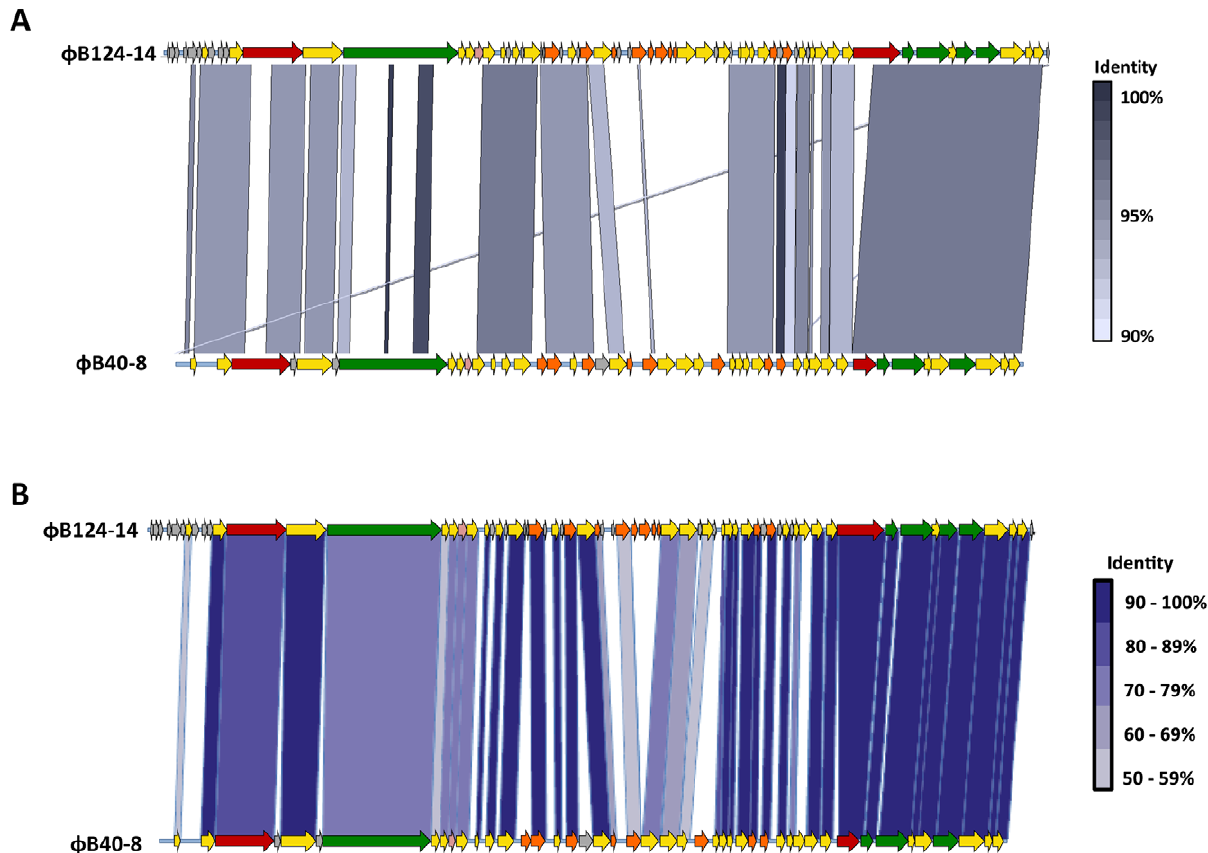
Figure 5. Comparative genomic analysis of W B124-14 and W B40-8 (ATCC 51477-B1). A. Nucleotide sequences of w B124-14 and w B40-8 were compared using the Artemis Comparison Tool (ACT). Shaded areas between linear phage genome maps represent areas of high nucleotide identity (90% or greater). Colour scale represents level of nucleotide identity at each region of homology. The ORF map for w B40-8 corresponds to the annotations available in the GenBank submission (FJ008913.1). For the purposes of this analysis, the w B124-14 genome was linearised between ORFs 29 and 30 (Figure 2, Table S2), in order to compare the circular w B124-14 genome with that of w B40-8. Colours of ORFs correspond to functional assignments as used in Figure 2. B. Comparison of amino acid sequences from w B124-14 ORFs with those annotated in the w B40-8 genome. Shading between arrows indicates those sharing high amino acid sequence identity. Colour scale indicates level of amino acid identity between each homologous ORF.